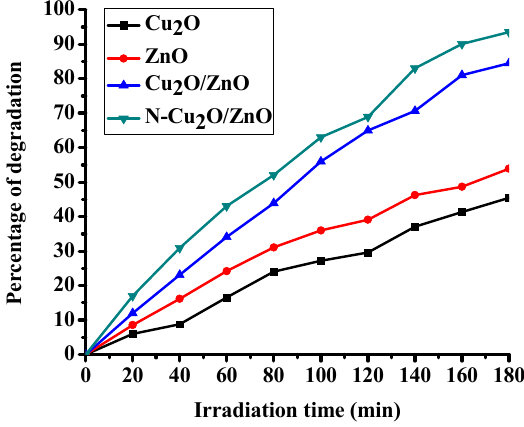
Figure 7. Evaluation of photocatalytic properties of ZnO, Cu 2 O, Cu 2 O/ZnO and N-doped Cu 2 O/ZnO on the degradation of methyl red under solar light .